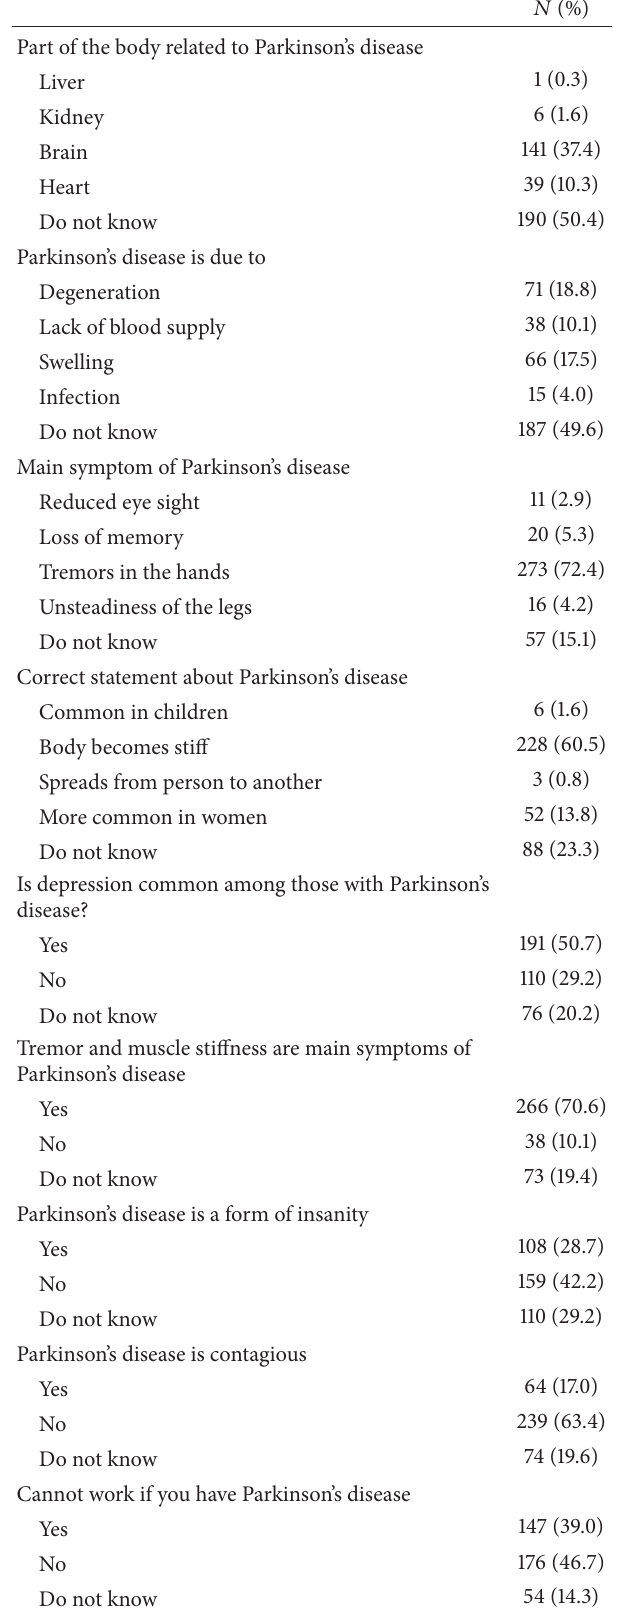
Table 1: Demographic characteristics of the study participants ( 𝑁 = 377 ).